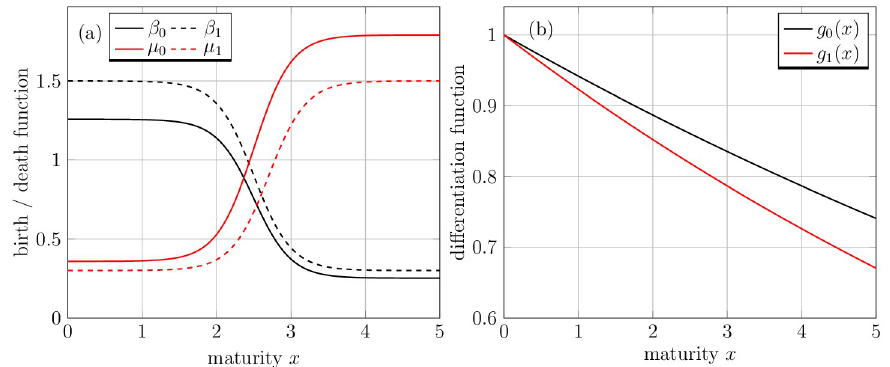
Fig 2. Birth, death and differentiation functions for progenitor cells. (a) Birth and death functions for both, healthy and mutated progenitor cell populations. The solid black and red lines represent the birth and death rate of healthy progenitor cell population, respectively, whereas the dotted black and and red lines depict the birth and death rate of mutated progenitor cells. (b) Differentiation function of healthy and mutated progenitor cell populations represented by black and red line,